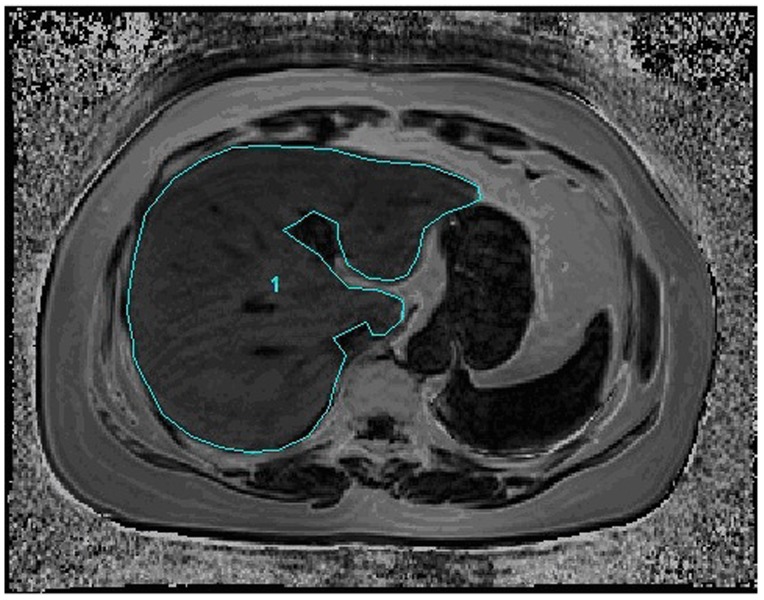
Irregular-shaped Regions of Interest (ROI) (1) covering the entire liver was placed in 21 consecutive slices (max-area centered) on the fat volume fraction (FVF) map of a typical patient.The average FVF in the ROI was recorded.